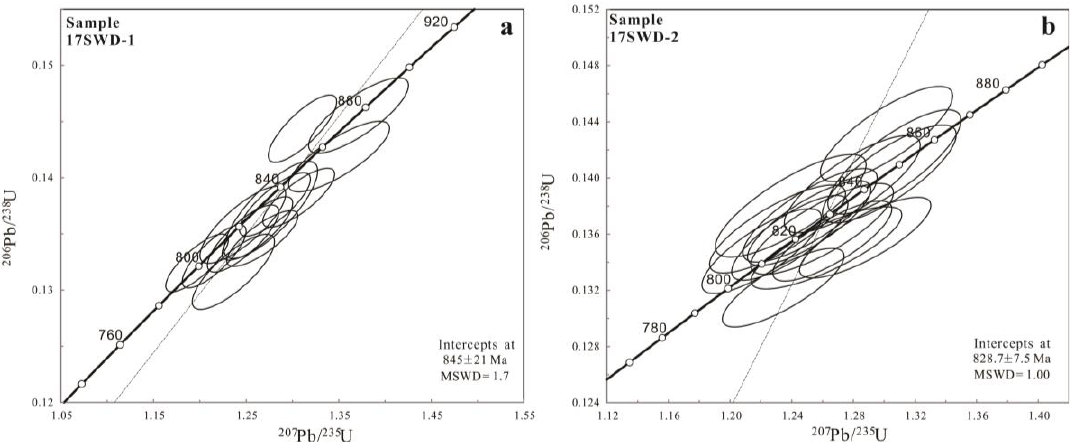
Figure 8. U-Pb concordance diagram of zircons from Jiningian granodiorite ( a ) Samlple 17SWD-1 and ( b ) Sample 17SWD-2.